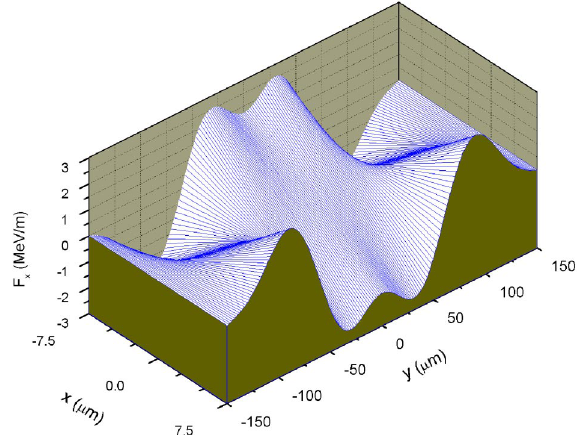
on x and y at z (cid:3) z